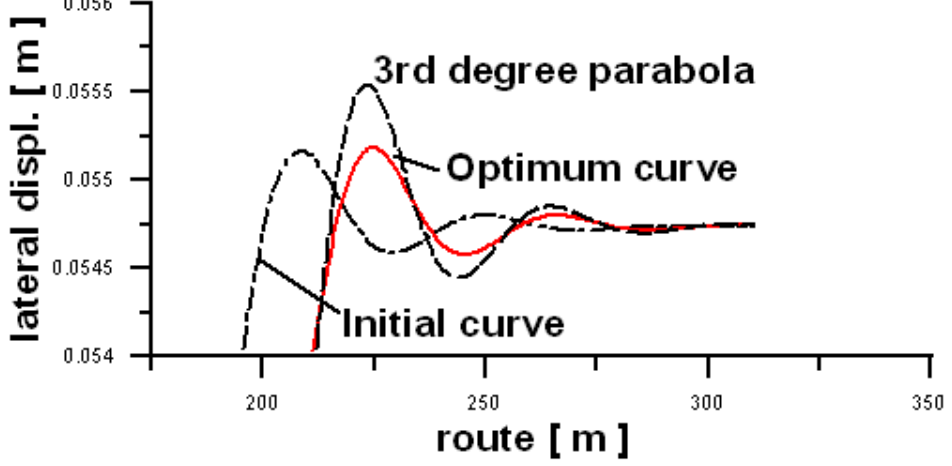
Figure 11. Maximum displacements from Figure 9 under magnification.